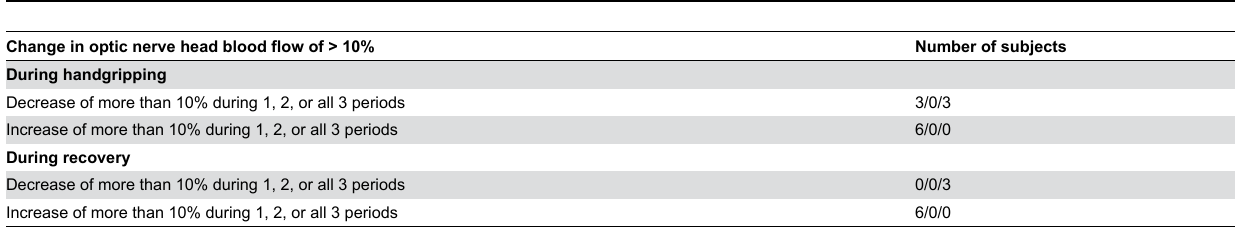
Table 4. Frequency of abnormal blood flow changes of more than 10% (n=39).